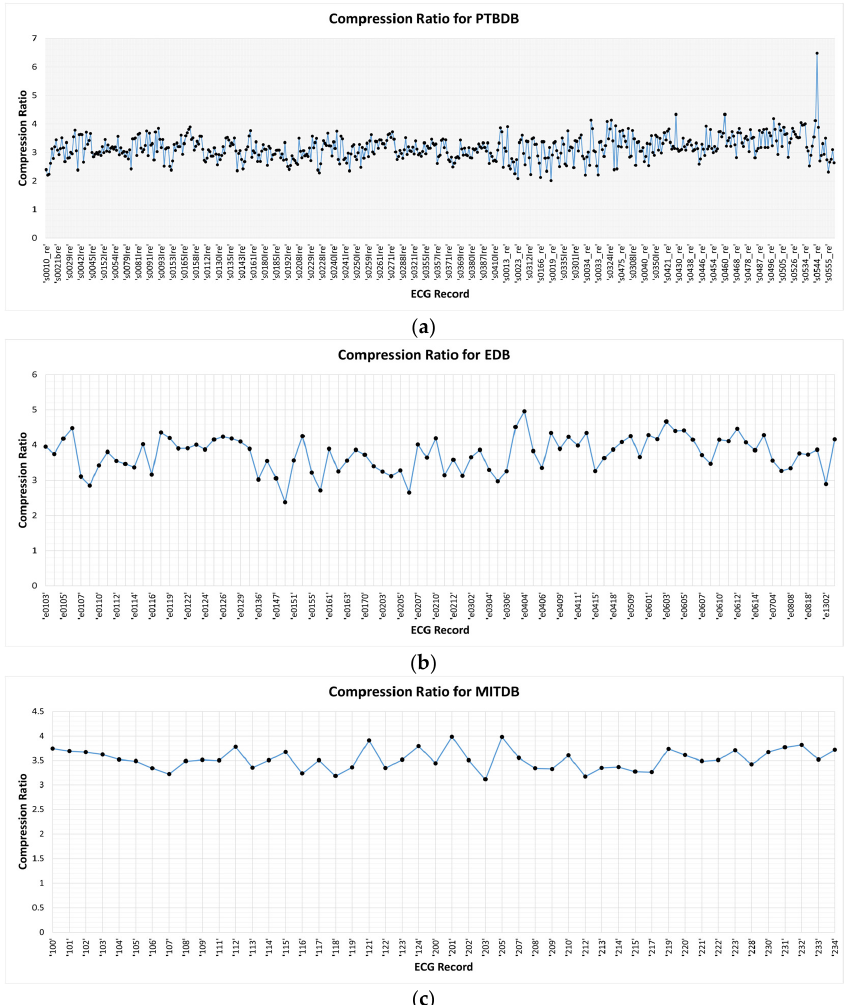
Figure 8. Compression ratio for each record of the data sets ( a ) PTBDB, ( b ) EDB, ( c ) MITDB. Table 1. The comparison of the average compression ratio to other methods on PTBDB data set. Ref.